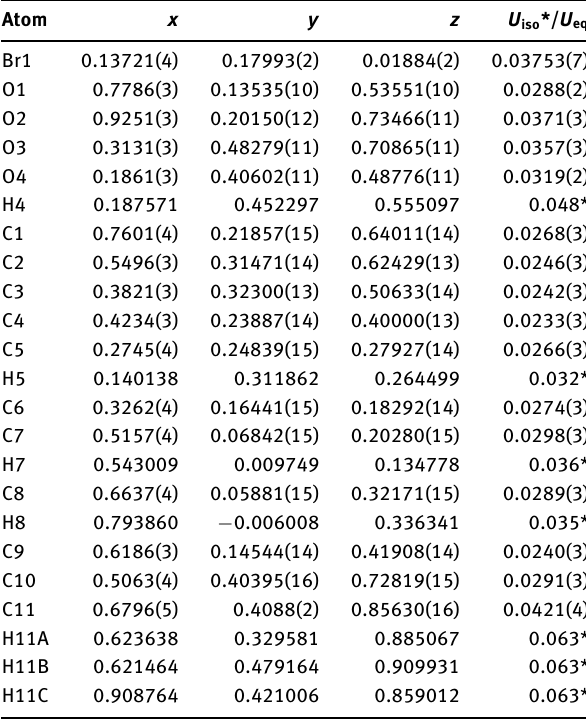
Table 2: Fractional atomic coordinates and isotropic or equivalent isotropic displacement parameters (Å 2